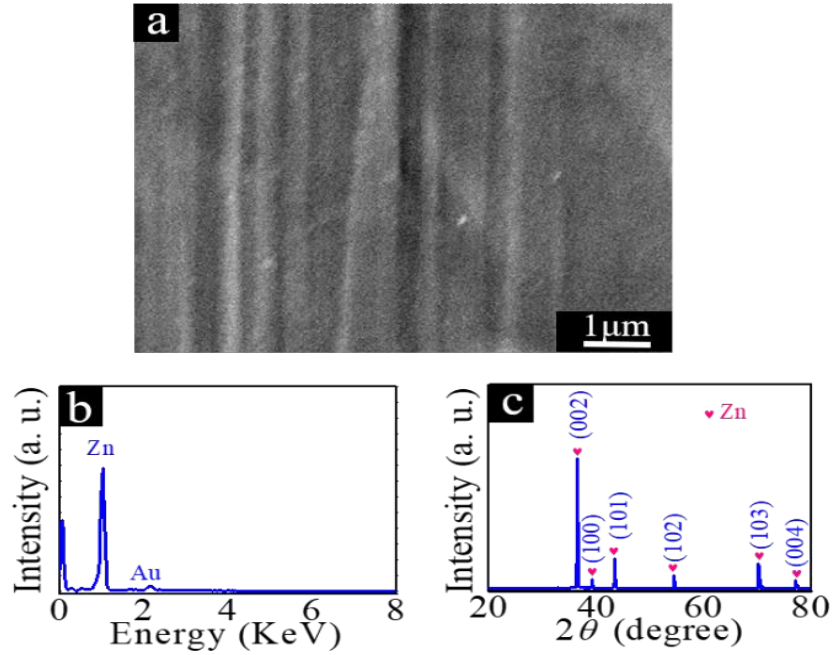
Figure 1. ( a ) SEM image of zinc foil, ( b ) EDX spectrum, and ( c ) XRD diffraction patterns of zinc